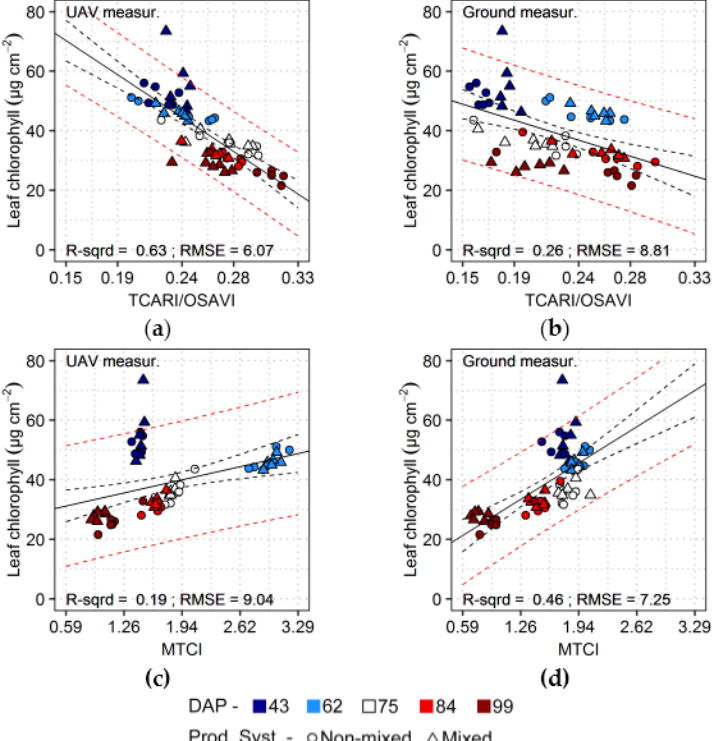
Figure 6. Best vegetation indices for prediction of leaf chlorophyll content from UAV and ground-based data ( a , d , respectively) and corresponding results for ground-based and UAV measurements ( b , c , respectively). Red and black dashed lines indicate prediction and confidence intervals with 95% confidence level, respectively.